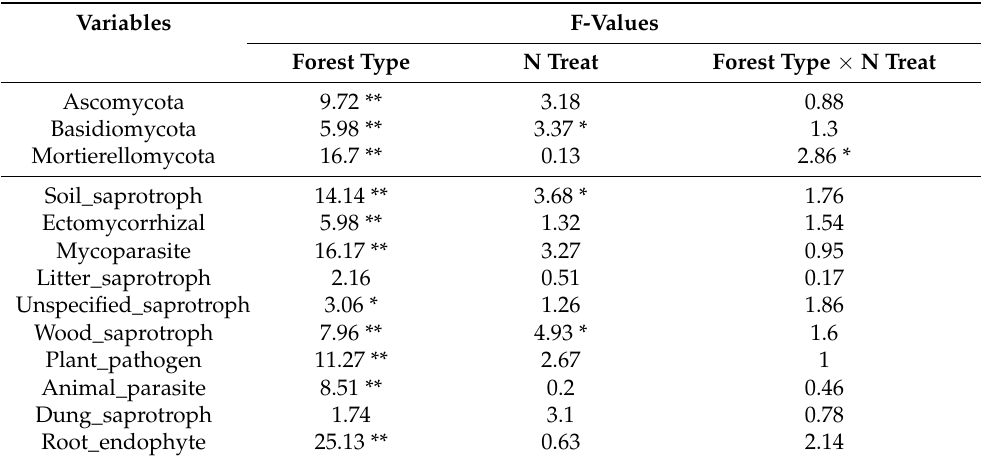
Table 3. Effects of forest types, N treatments, and their interactions on variables (i.e., the relative abundance of dominant fungal phyla and functional groups) based on two-way analyses of variance (ANOVAs). Level of significance: * p < 0.05, ** p < 0.001. Variables F-Values Forest